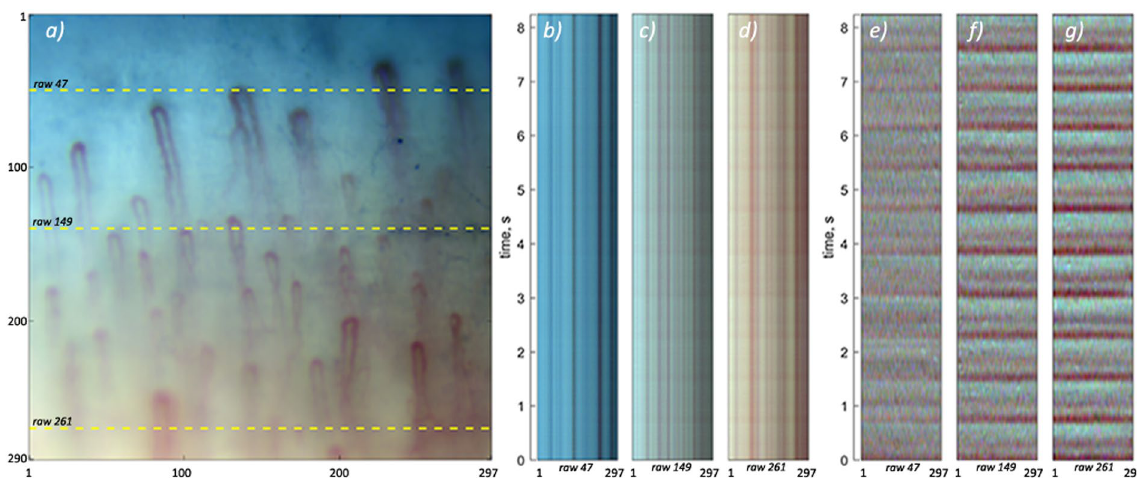
Figure 3. Time-varying modulation of pixel values. ( a ) One of the microscopic images excerpted from the recorded video. ( b ), ( c ), and ( d ) Diagrams showing temporal evolution of pixel values in three rows 47, 149, and 261 marked by dashed lines. ( e ), ( f ), and ( g ) Diagrams with alternating components of the pixel values for the same selected